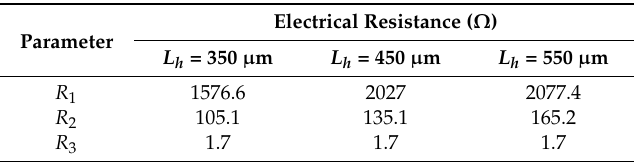
Figure 4. Schematic of equivalent electrical circuit of an electrothermal actuator. Table 1. Resistance values of the equivalent electrical circuit of an electrothermal actuator considering the following dimensions: ω h = 2 μ m, ω c = 30 μ m and t h = t c = 2.25 μ m.